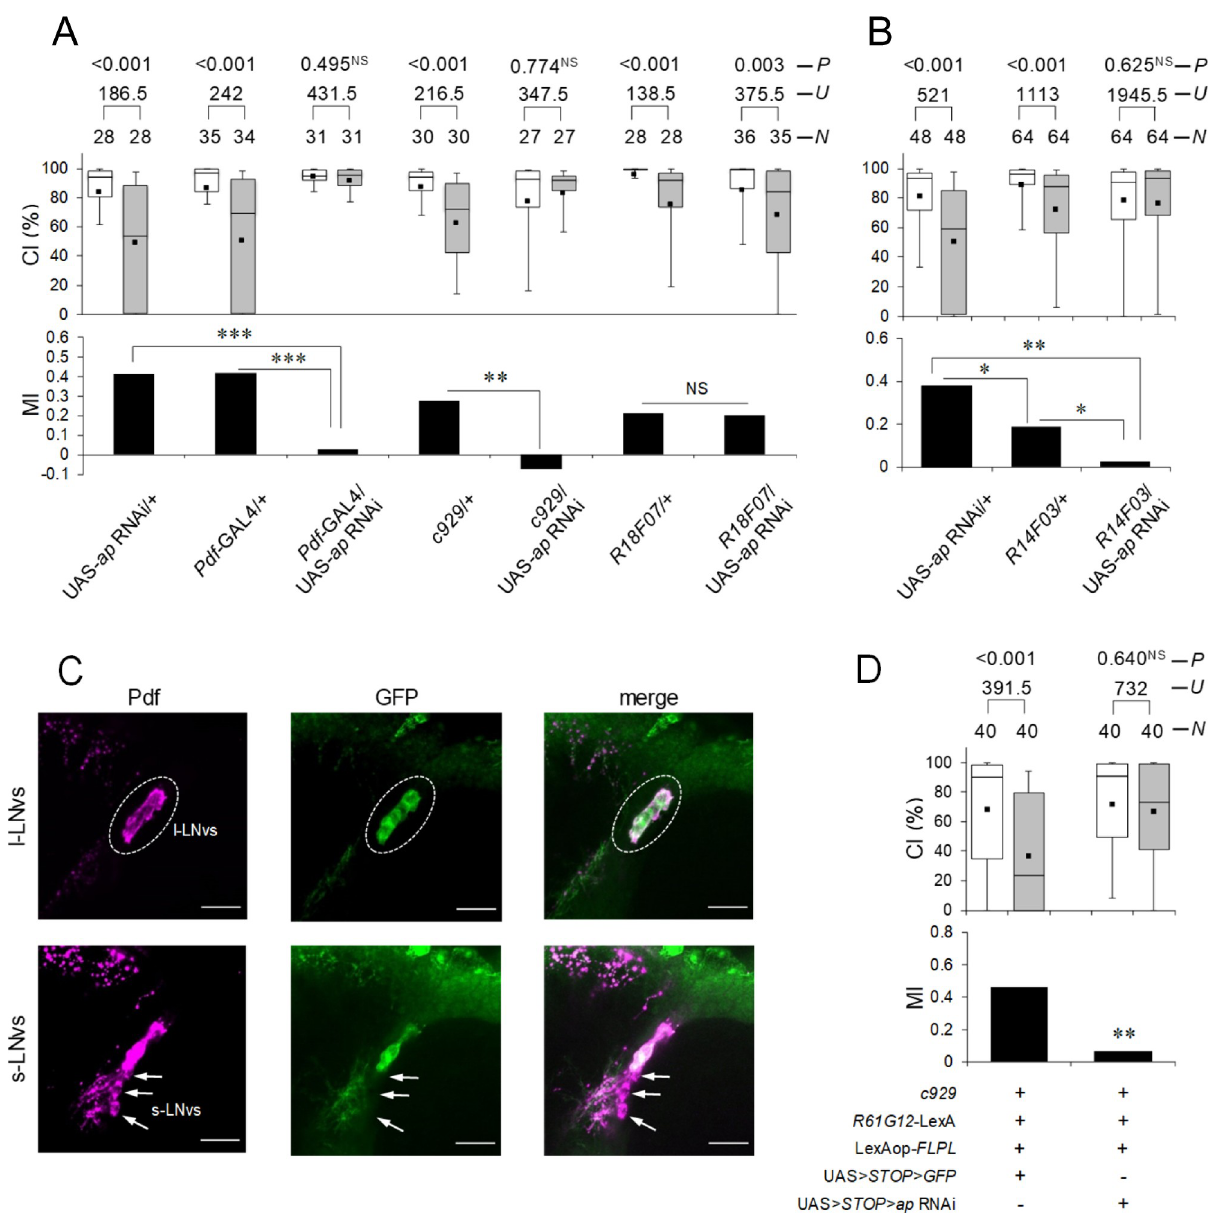
Fig 4. ap knockdown in Pdf-positive l-LNvs induces LTM impairment. (A) Five-day memory after 7-hour conditioning. ap RNAi was driven by Pdf - GAL4, c929 , and R18F07 . Box plots for a set of CI data show 10th, 25th, 75th, and 90th centiles. In the box plots, the black square in each box indicates the mean, the line in each box is drawn at the median, the white boxes indicate naive males, and the gray boxes indicate conditioned males. CI, courtship index; MI, memory index; N , sample size; U , Mann–Whitney U ; P , probability; �� , P < 0.01; ��� , P < 0.001; NS, not significant. (B) Five-day memory after 7-hour conditioning. ap RNAi was driven by R14F03 . � , P < 0.05; �� , P < 0.01; NS, not significant. (C) l-LNv–specific expression of mCD8::GFP. c929 / R61G12 -LexA; LexAop- FLPL /UAS > STOP > mCD8 :: GFP flies were used. Brains were stained with an anti-Pdf antibody and an anti- GFP antibody. Magenta, Pdf; green, mCD8::GFP. Confocal section images at the level of Pdf neurons of the adult brain. Scale bars represent 10 μ m. (D) l-LNv–specific knockdown of ap . Five-day memory after 7-hour conditioning. c929 / R61G12 -LexA; LexAop- FLPL /UAS > STOP > ap RNAi flies were used. �� , P < 0.01; NS, not significant. (B and D) Box plots for a set of CI data show fifth, 25th, 75th, and 95th centiles. In the box plots, the black square in each box indicates the mean, the line in each box is drawn at the median, the white boxes indicate naive males, and the gray boxes indicate conditioned males. CI, courtship index; MI, memory index; N , sample size; U , Mann–Whitney U ; P , probability. (A, B, and D). The underlying data can be found in S1 Data. Ap, Apterous; l-LNv, large ventral–lateral clock neuron; LTM, long-term memory; Pdf, pigment dispersing factor; RNAi, RNA